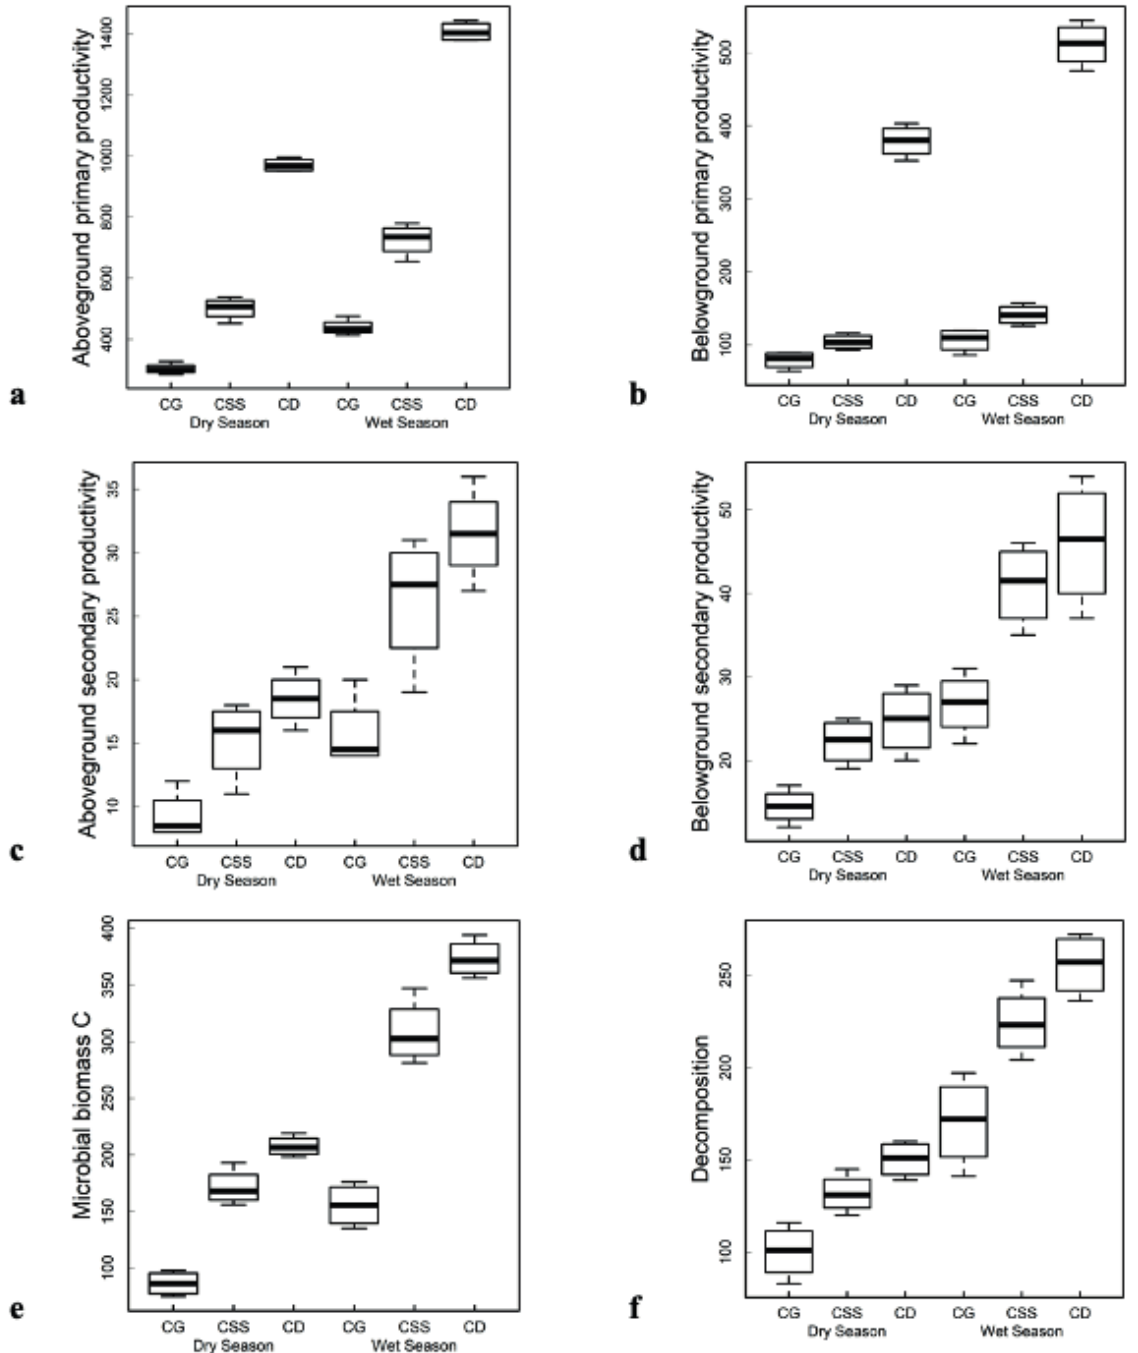
Figure 2. Ecosystem function between Cerrado physiognomies: Aboveground primary productivity (a), belowground primary productivity (b), aboveground secondary productivity (c), belowground secondary productivity (d), microbial biomass C (e) and decomposition (f). Error bars represent the standard deviation of four independent